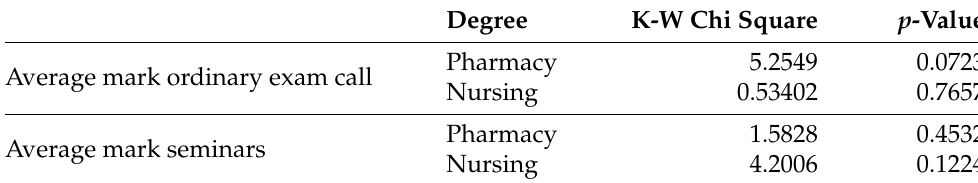
Table 15. Kruskal-Wallis non-parametric test results for mean marks.